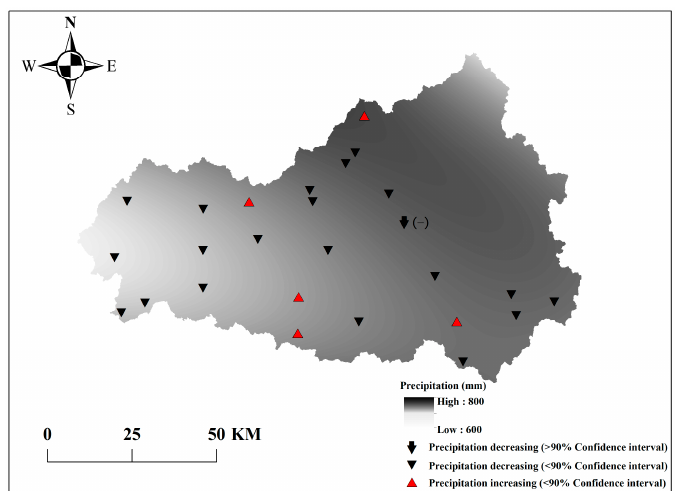
Figure 2. Precipitation ( a ) and streamflow ( b ) trend map of Dawen River Daicun Dam Basin.